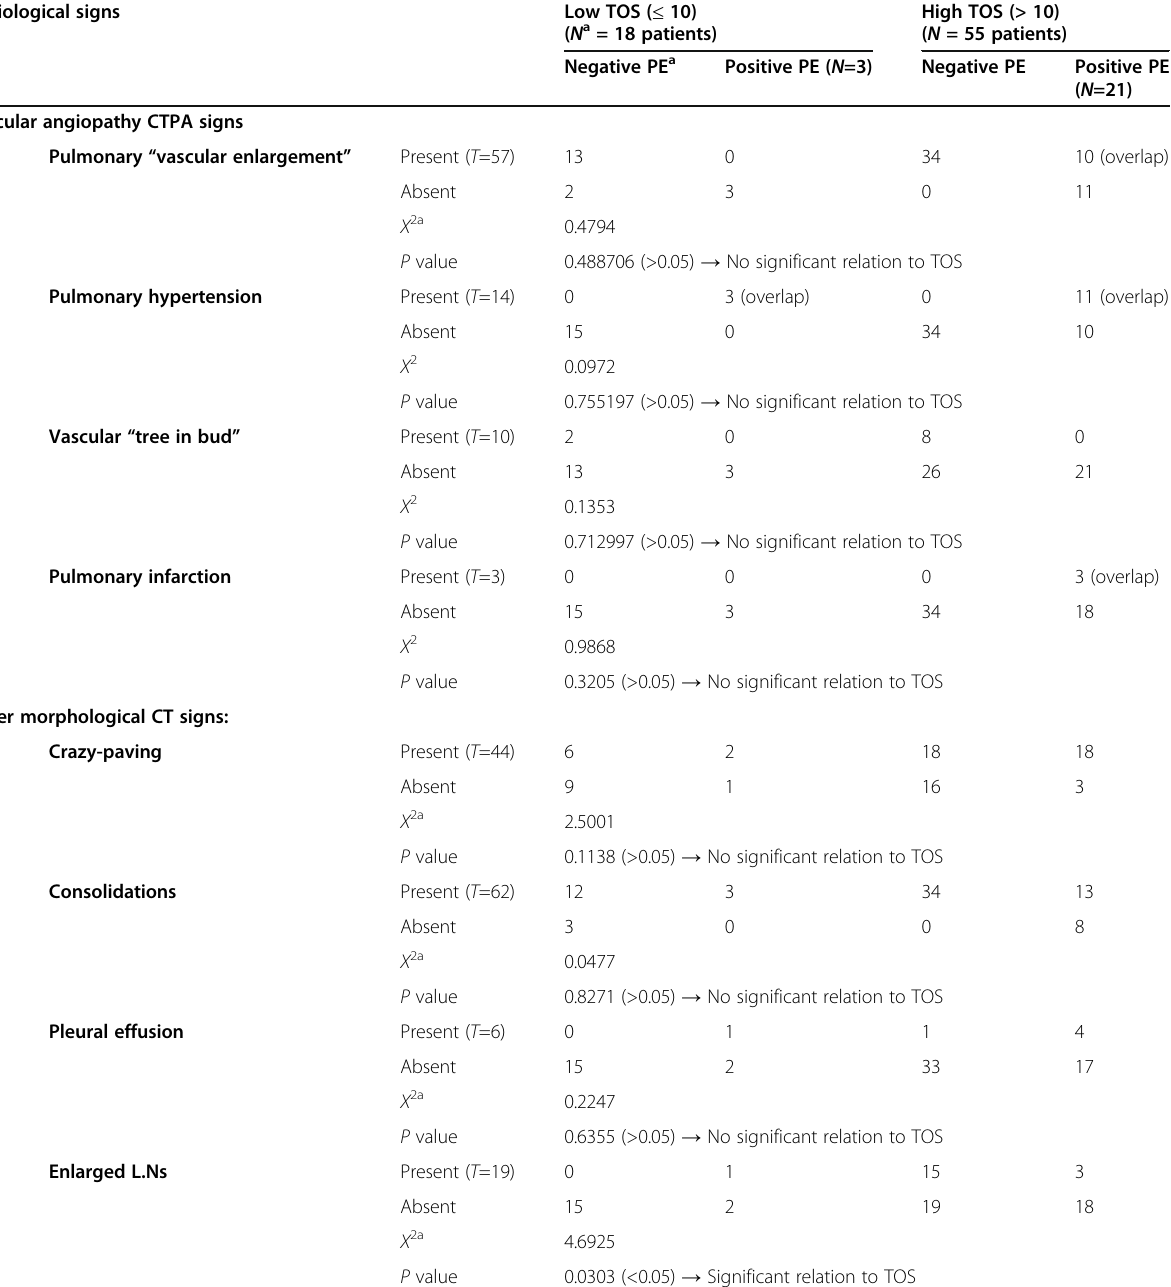
Table 3 Distribution of patients with vascular angiopathy and morphological CT signs according to low versus high TOS and negative versus positive pulmonary embolism with significant statistical analysis Radiological signs Low TOS ( ≤ 10)